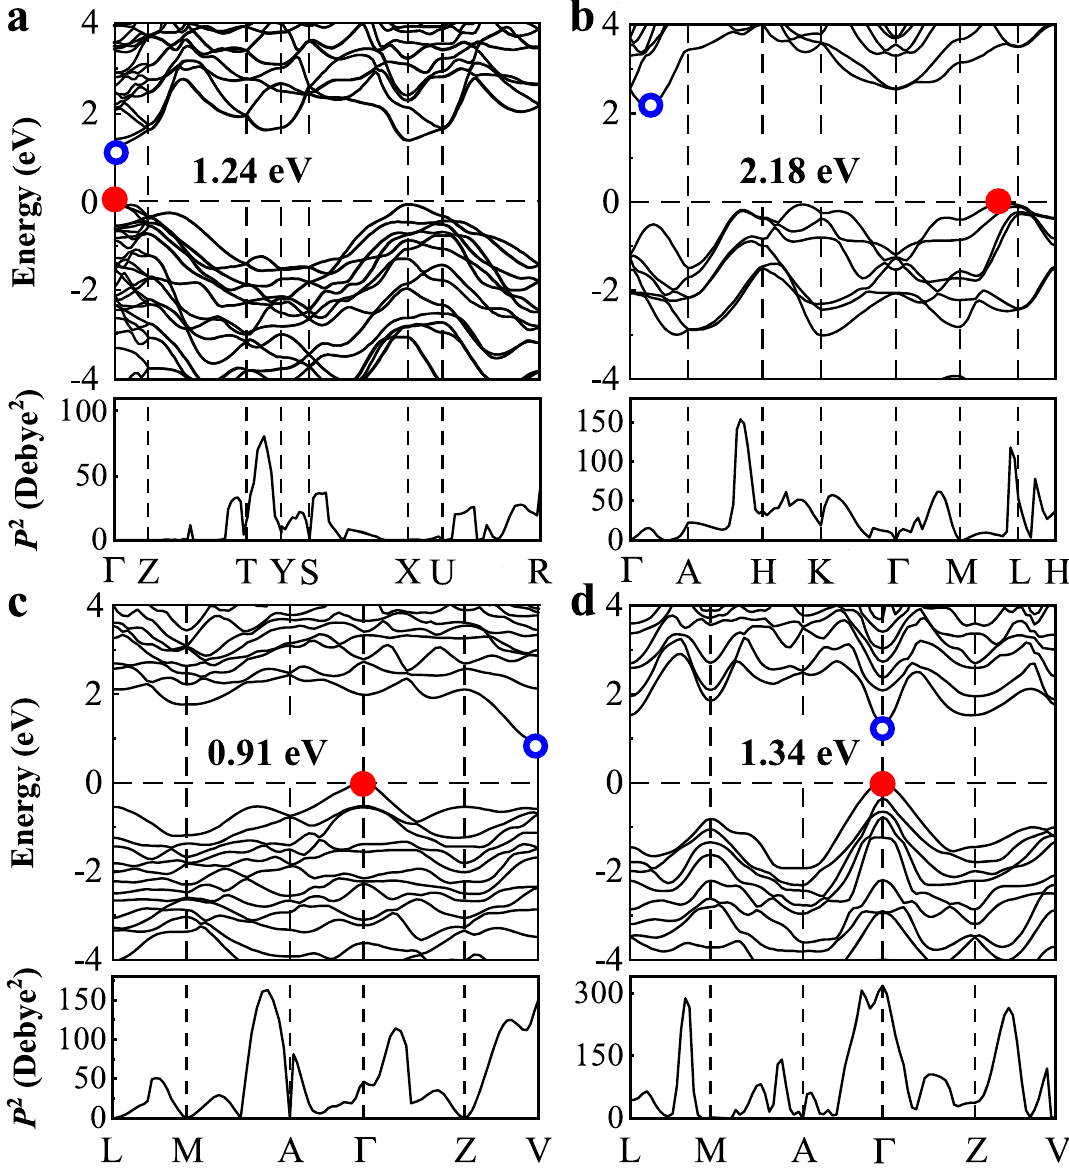
Fig. 5 Electronic properties of the Si 2 He compound. Electronic band structures of a oP36-Si 2 He, b tP9-Si 2 He, c mC18-Si 2 He, and d mC12- Si 2 He at 0 GPa calculated based on the HSE06 functional. Red solid and blue hollow circles represent the valence band maximum and conduction band minimum, respectively. The lower panels in each fi gure are the square of the transition dipole moment 89